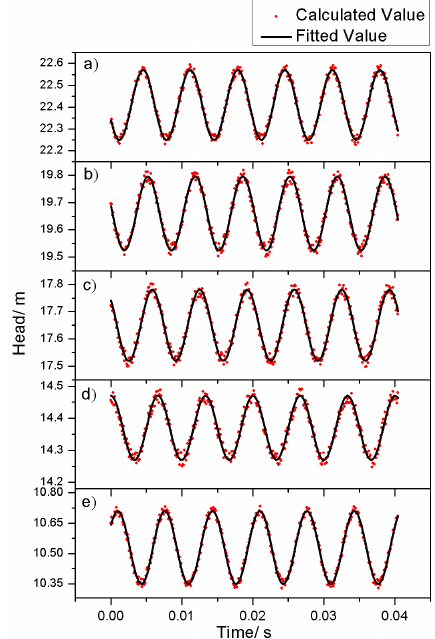
Figure 7. Fluctuation of head in one shaft rotation cycle at different working points: ( a ) 0.6 Q des ; ( b ) 0.8 Q des ; ( c ) 1.0 Q des ; ( d ) 1.2 Q des ; ( e ) 1.4 Q des .